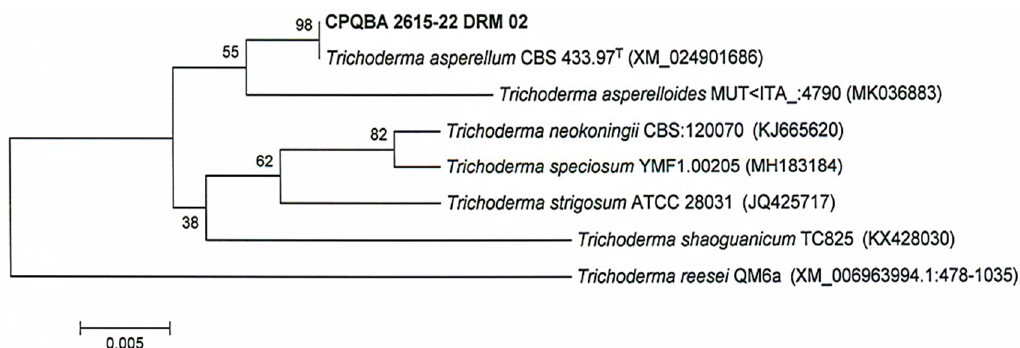
Figure 2. Dendrogram based on genetic distance using the neighbor-joining method to demonstrate the relationship between the partial sequence of the TEF region of the CPQBA 2615-22DRM sample and sequences of related microorganism strains present in the MycoBank (CBS KNAW, actual Westerdijk Fungal Biodiversity Institute) and GenBank databases.